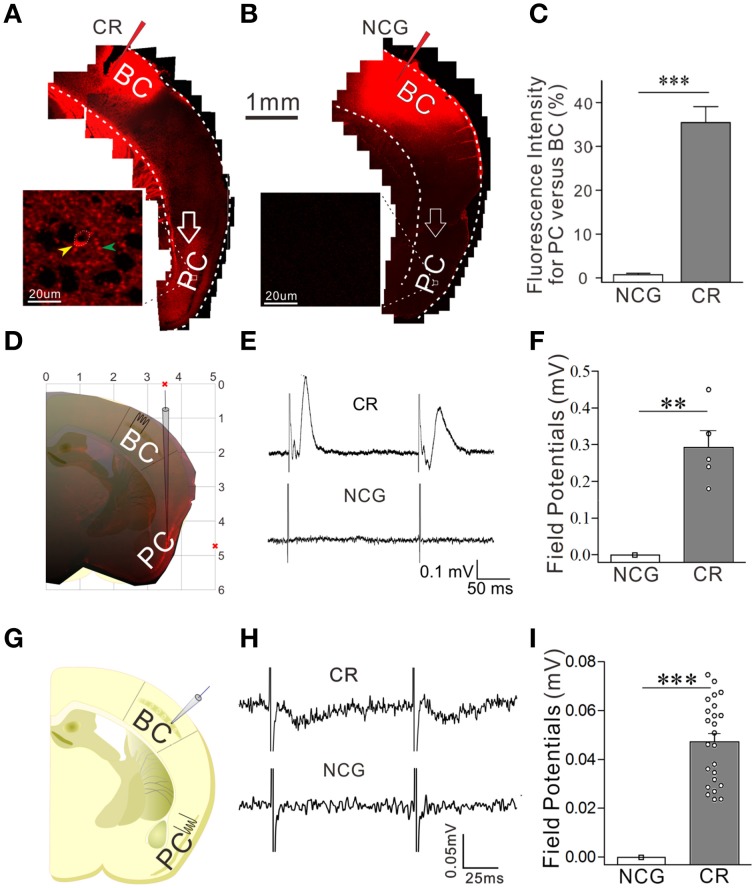
The connection between the barrel and piriform cortices is established after associative learning. The structural connection was traced by injecting 1,1′dioctadecyl-3,3,3′,3-tetramethylindocarbocyanine perchlorate into the barrel cortex and seeing its presence in the piriform cortex. The functional connection was examined by recording LFP in the piriform cortex and electrically stimulating the barrel cortex in vivo, or turned around. In in vivo recordings, bipolar tungsten electrodes were placed in barrel cortex, and glass recording electrodes (10 MΩ) were positioned into the piriform cortex (0.34–0.58 mm posterior to the bregma, 3.25–3.5 mm lateral to midline, and 4.75–5.0 mm in depth). (A) Shows neural tracing from the barrel cortex to the piriform cortex in CR-formation mouse. An arrow points fluorescent labeling in the piriform cortex. Left panel shows an enlarged image from the piriform cortex which includes DiI-labeled neuron (yellow arrow) and DiI-labeled axons (green arrow). (B) Shows the neural tracing from the barrel cortex to the piriform cortex in a NCG mouse. An arrows indicates no fluorescent labeling in the piriform cortex. (C) Shows the comparison of neural tracing in the piriform cortex from CR-formation mice (n = 9, gray bar) and NCG mice (n = 9, white), based on relative fluorescent intensity. (D) Shows LFP recording in the piriform cortex by a glass pipette of including DiI and the electrical stimulation in the barrel cortex in vivo. (E) Top trace shows LFP in the piriform cortex recorded from a CR-formation mouse and bottom trace shows no LFP recorded in the piriform cortex from a NCG mouse. (F) Illustrates the comparison of LFPs recorded in the piriform cortex from CR-formation group (n = 5 recordings from three mice, gray bar) and NCG (n = 6 recordings from three mice, white bar). (G) Shows LFP recording in the barrel cortex and electrical stimuli in the piriform cortex in the brain slices. (H) Top trace shows LFP in the barrel cortex recorded from a CR-formation mouse, and bottom trace shows no LFP recorded in the barrel cortex from a NCG mouse. (I) Illustrates the comparisons of electrical signals recorded in the barrel cortex from CR-formation mice (n = 23 recordings from five mice, gray bar) and NCG mice (from five mice, white). **p < 0.01; ***p < 0.001.